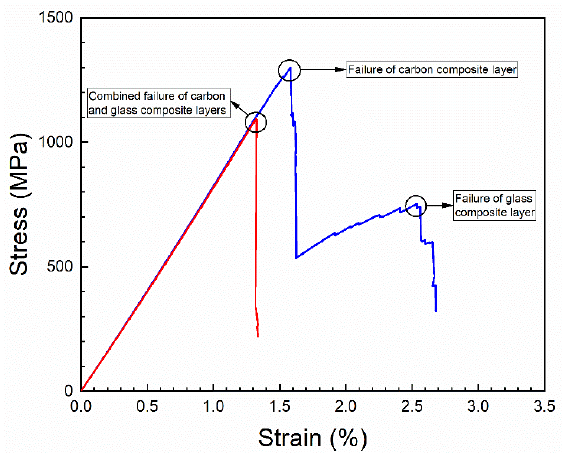
Figure 7. Representative stress–strain curves showing the two failure modes in the protected carbon composites: single failure mode (red) and double failure mode (blue).